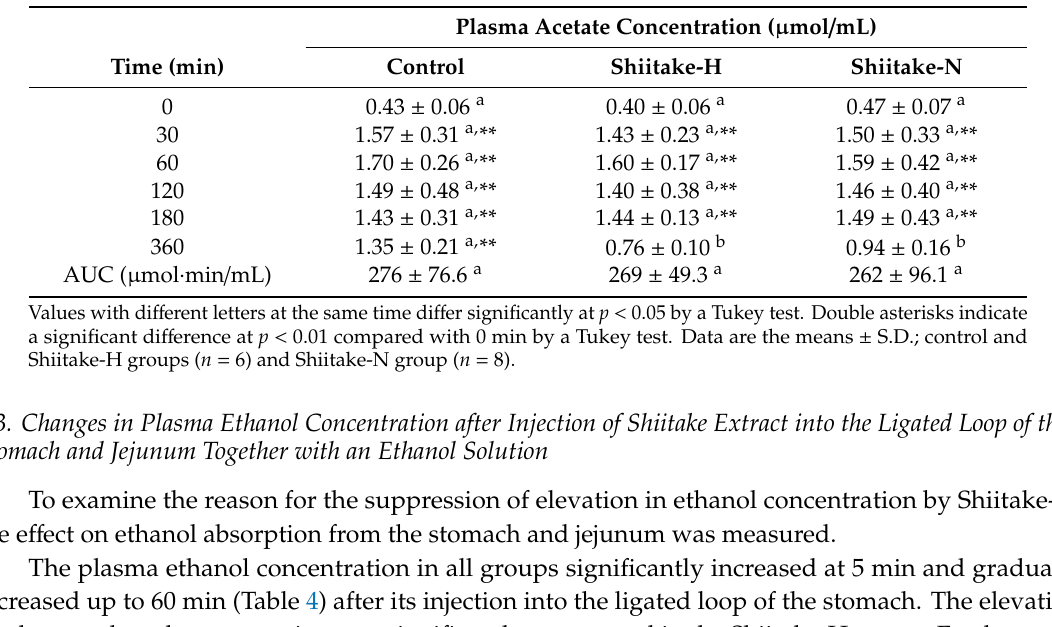
Table 3. E ff ect of shiitake extract on plasma acetate concentration after oral administration of